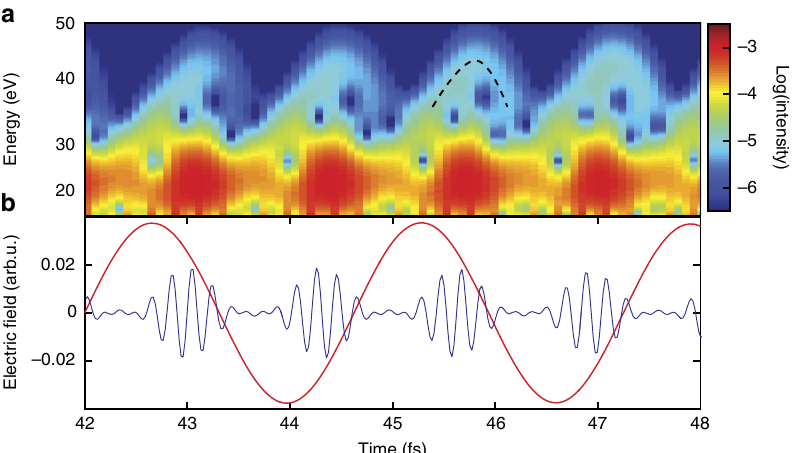
Fig. 6 Time – frequency analysis of the Schrödinger equation simulation. a Gabor time – frequency distribution as a function of time and photon energy for Δ t = − 1575 as ( − 0.6 IR cycles), presented in logarithmic scale. At high energies > 30 eV, the arch-like structures indicate that XUV emission occurs predominantly as a result of strong- fi eld acceleration. Qualitatively, we fi nd agreement of the emission time from the analysis with recombination times of a classical three-step model (illustrated by the dashed black curve). b Input IR and XUV fi elds in arbitrary